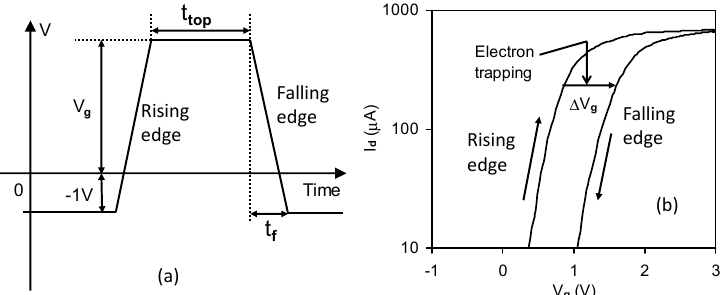
Figure 37. ( a ) The gate bias waveform; ( b ) the pulse Id-Vg recorded at the rising and falling edges of the gate bias [25].